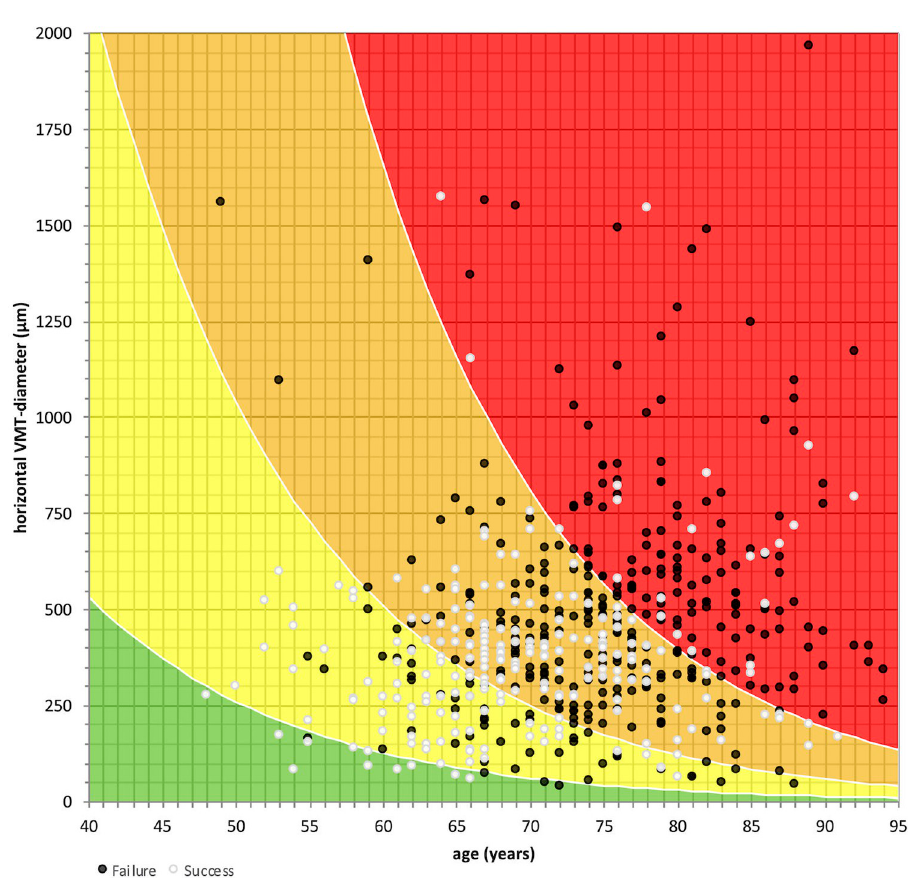
Fig 3. Two-dimensional plot of the probability of successful treatment with ocriplasmin. The calibrated EXPORT multivariable model was used to calculate the probability of successful treatment (grouped in 25% intervals; red: intravitreal ocriplasmin (IVO) success group: 0% to 25%, orange: 25% to 50%, yellow: 50% to 75%, and green: 75% to 100%) with a dependence on age (x-axis) and horizontal vitreomacular traction (VMT) diameter (y-axis). Overlaid are all 591 patients arranged by their age (x-axis) and horizontal VMT diameter (y-axis). The treatment outcome is displayed by the marking: patients in which IVO treatment was successful (VMT resolution) are marked by white dots, those in which treatment was not successful (VMT persistence) are marked with black